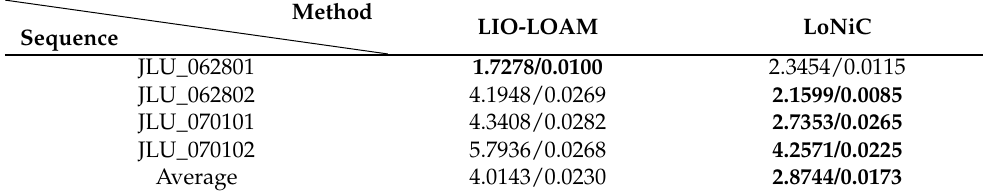
Table 6. Relative pose error of LIO-LOAM and LoNiC on the JLU campus dataset.